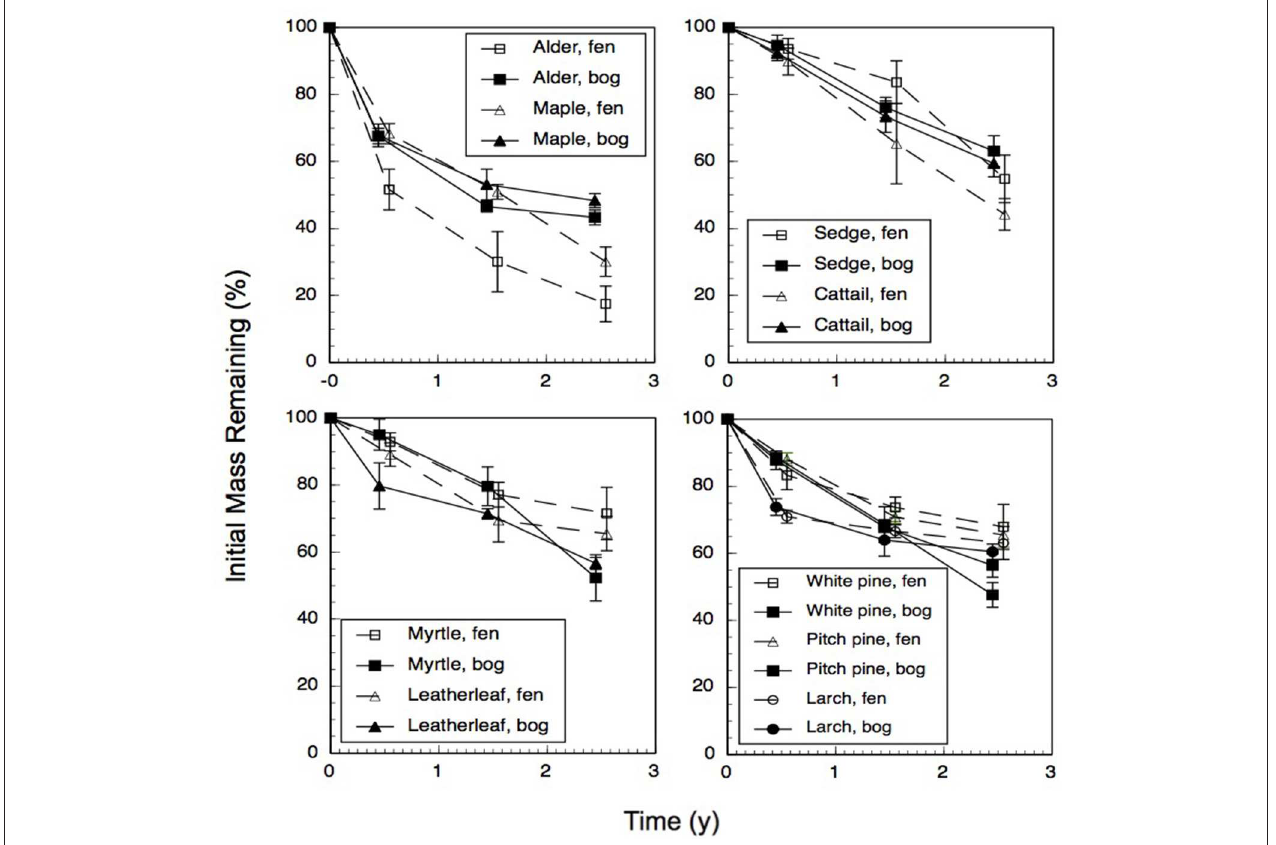
FIGURE 1 | Percentage of initial mass remaining for leaf litter from nine plant species having decayed in bogs or in rich fens for three amounts of time. Values are mean + standard error; n = 10 for 0.5 year, n = 4 for 1.5 years, n = 5 for 2.5 years.